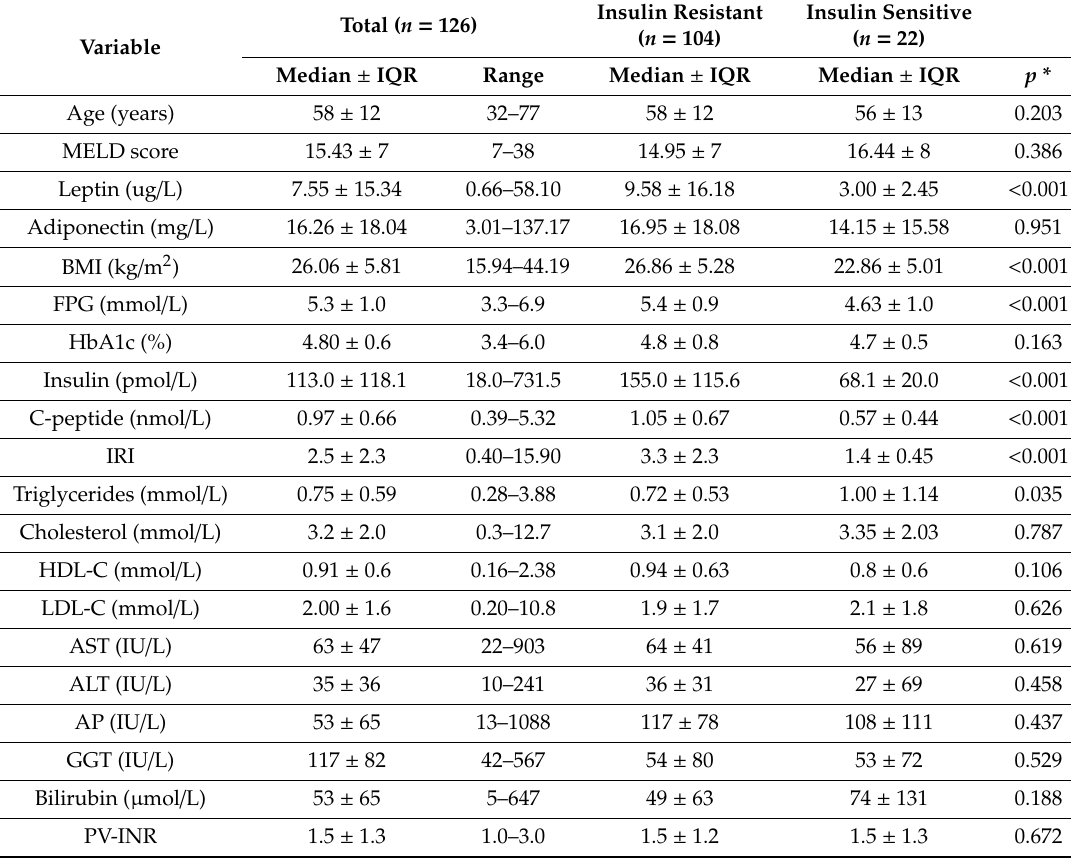
Table 2. Characteristics of the patients with liver cirrhosis overall and according to insulin resistance (IRI cut-o ff 1.7).